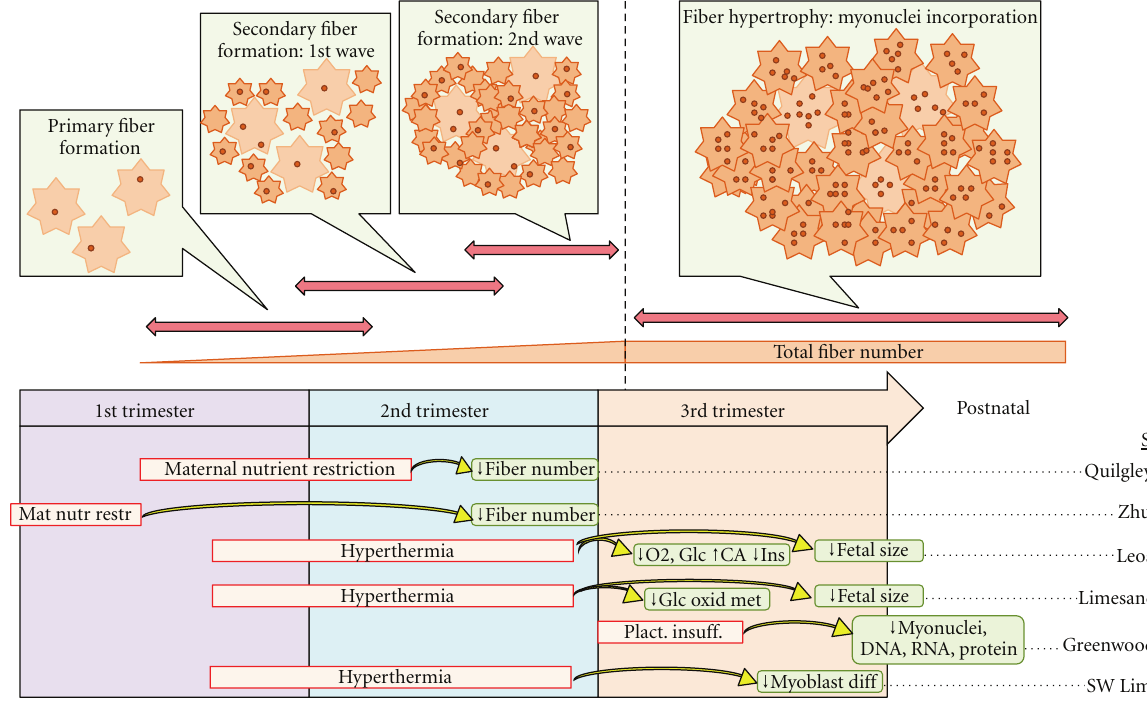
Figure 1: The stages of skeletal muscle formation relative to gestational age are depicted by the horizontal arrows and schematic diagrams (fascicular cross-sections) for the developmental process. The vertical dashed line represents the completion of myogenesis (new fiber formation) and onset of hypertrophic fiber growth. The timing, duration, and type of nutritional insult (red boxes) reported in various studies are presented below the gestational timeline, along with the fetal consequences (blue